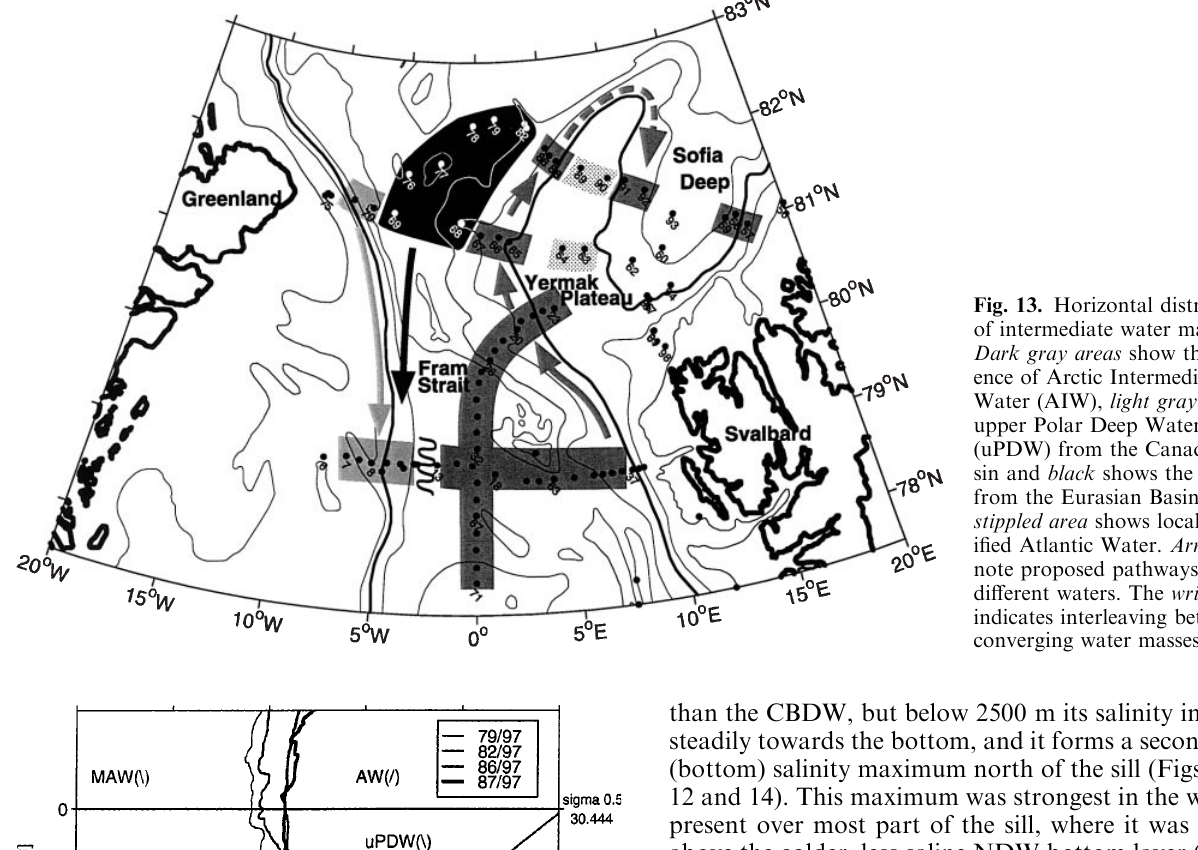
Fig. 13. Horizontal distribution of intermediate water masses. Dark gray areas show the pres- ence of Arctic Intermediate Water (AIW), light gray denotes upper Polar Deep Water (uPDW) from the Canadian Ba- sin and black shows the uPDW from the Eurasian Basin. The stippled area shows locally mod- ified Atlantic Water. Arrows de- note proposed pathways of the di(cid:128)erent waters. The wriggly line indicates interleaving between converging water masses